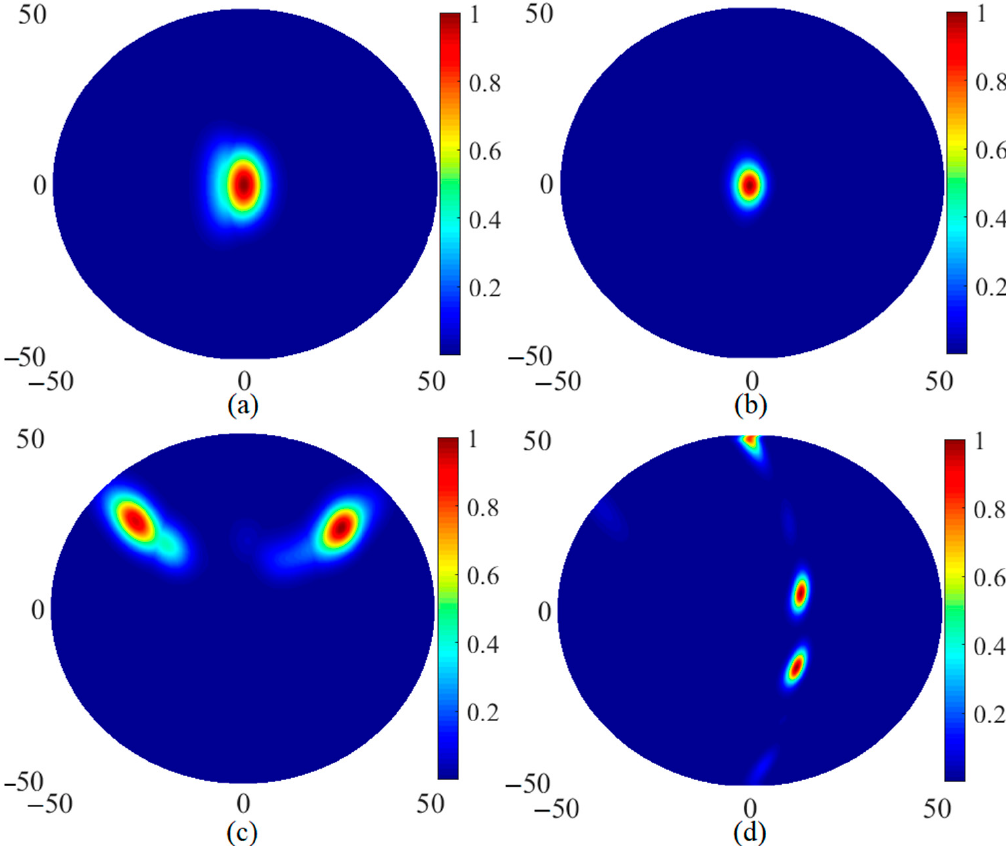
Figure 13. Reconstructed images using received signals from four arrays and a robust time reversal algorithm [47]: ( a ) central tumour with skin, ( b ) central tumour without skin, ( c ) two tumours and ( d ) three tumours.